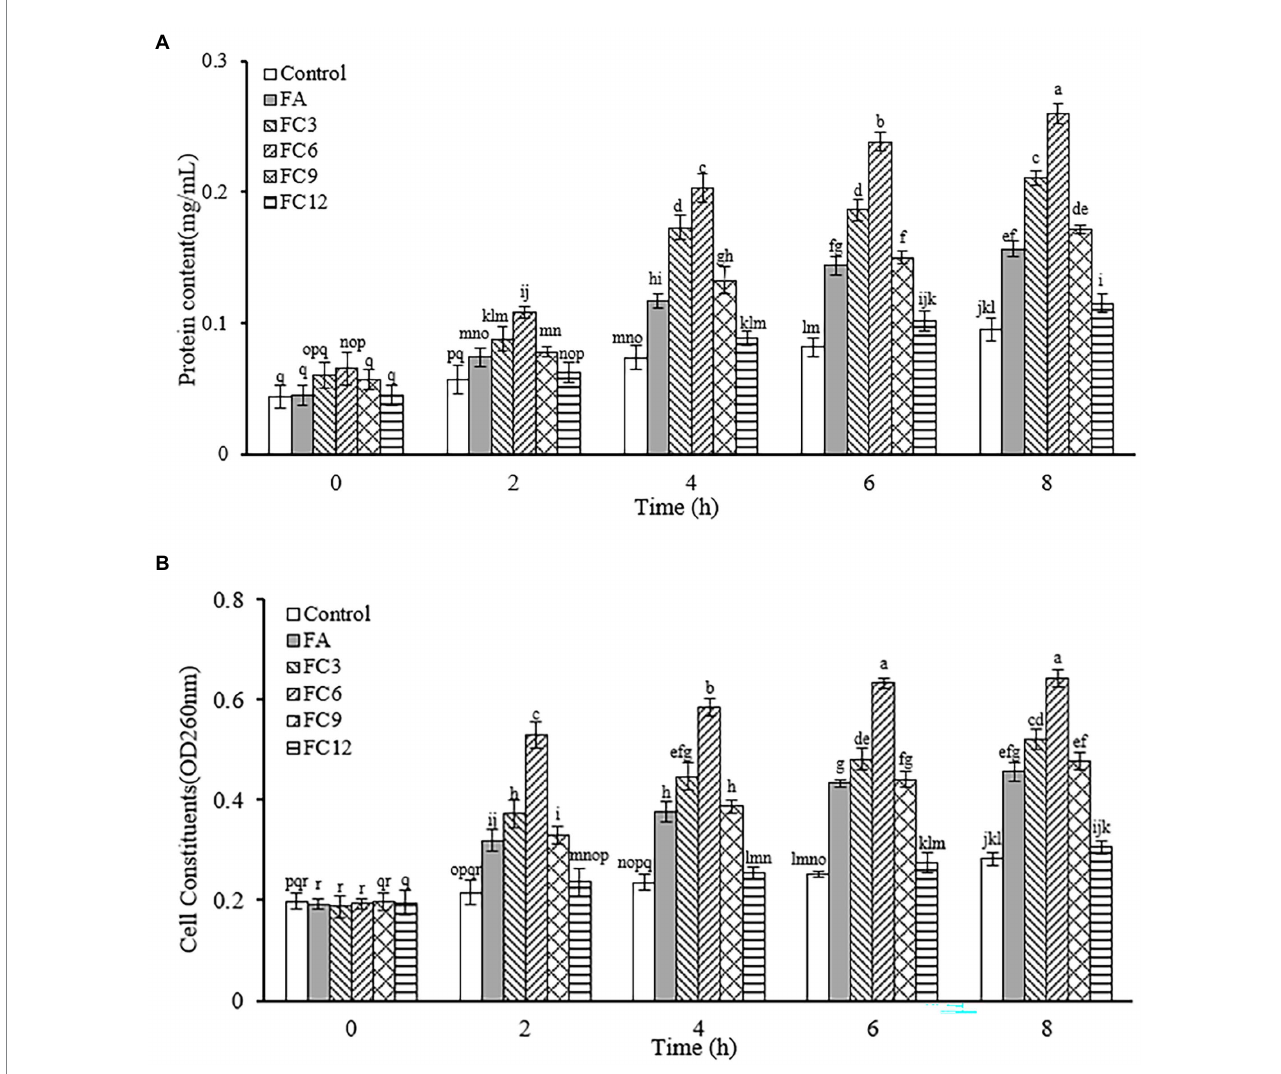
FIGURE 8 Effect on leakage of Pseudomonas aeruginosa cell contents. (A) Effect on protein leakage in Pseudomonas aeruginosa cells. (B) Effect on nucleic acid leakage of Pseudomonas aeruginosa